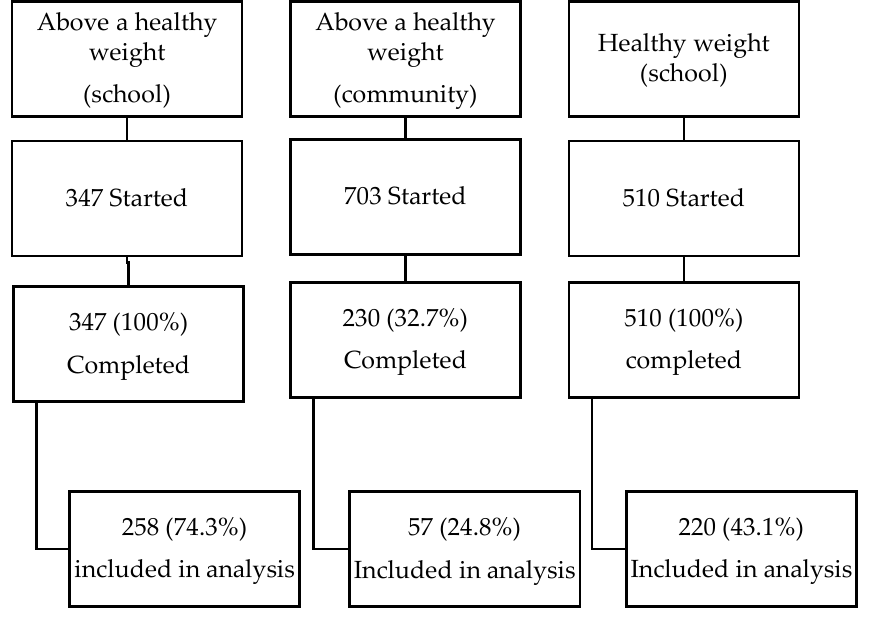
Figure 1. Participant flow chart. Table 2. Participant characteristics at